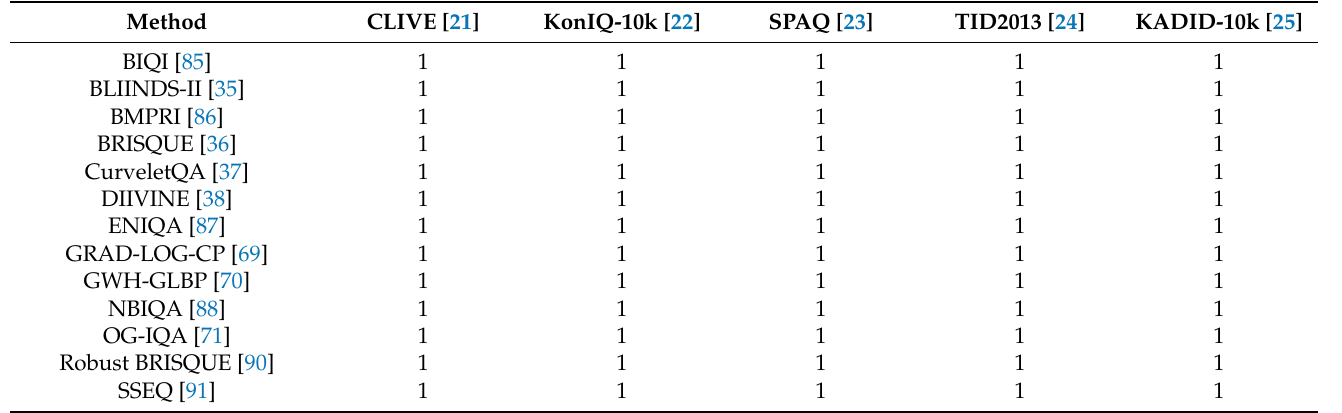
Table 6. Results of the two-sided Wilcoxon rank sum test. Symbol ‘1’ is used to denote that the proposed method—LFD-IQA-SVR—is significantly better than the method in the row on the database in the